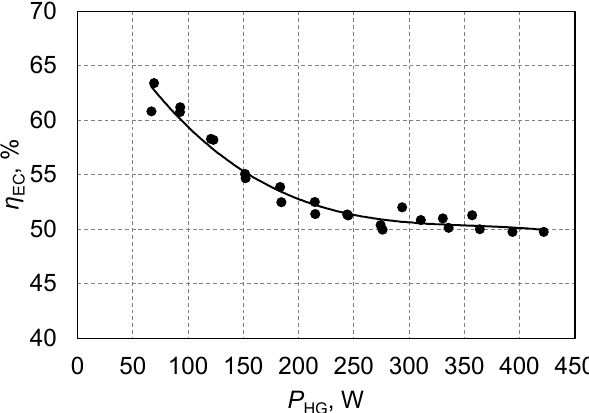
Figure 3. Electrolyzer efficiency as a function of hydrogen generator supply power.